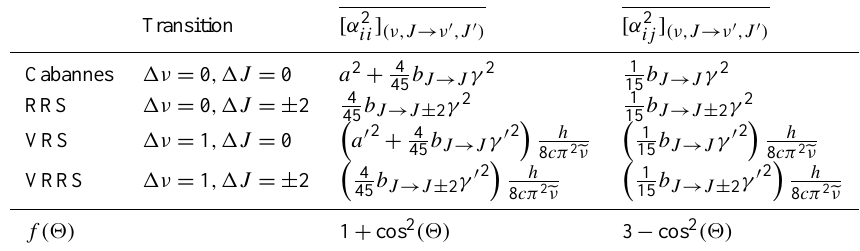
Table 5. Spatial averaged polarization tensor according to Long (2002) and corresponding phase functions f ((cid:50)) .